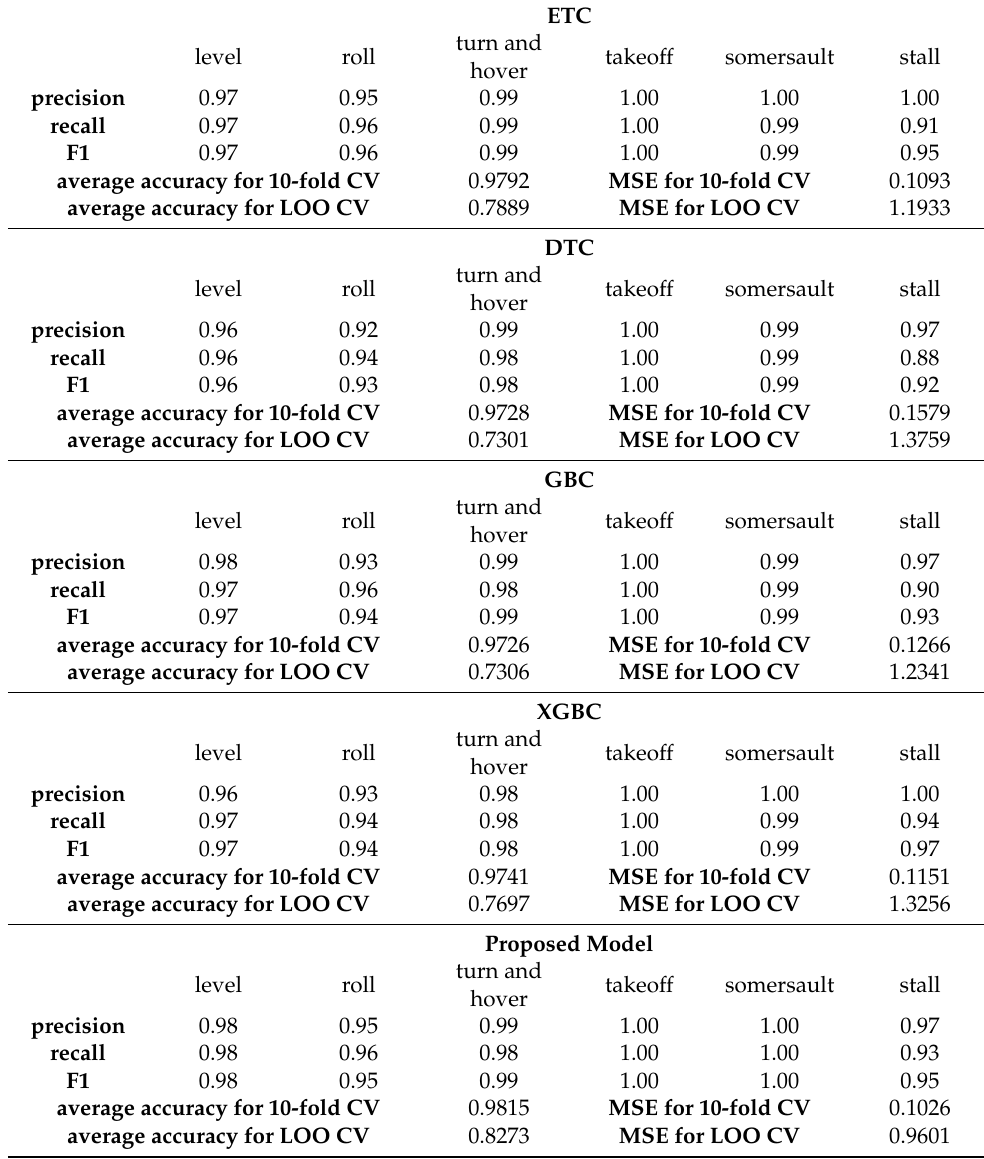
Table 9. The classification report of classifiers after